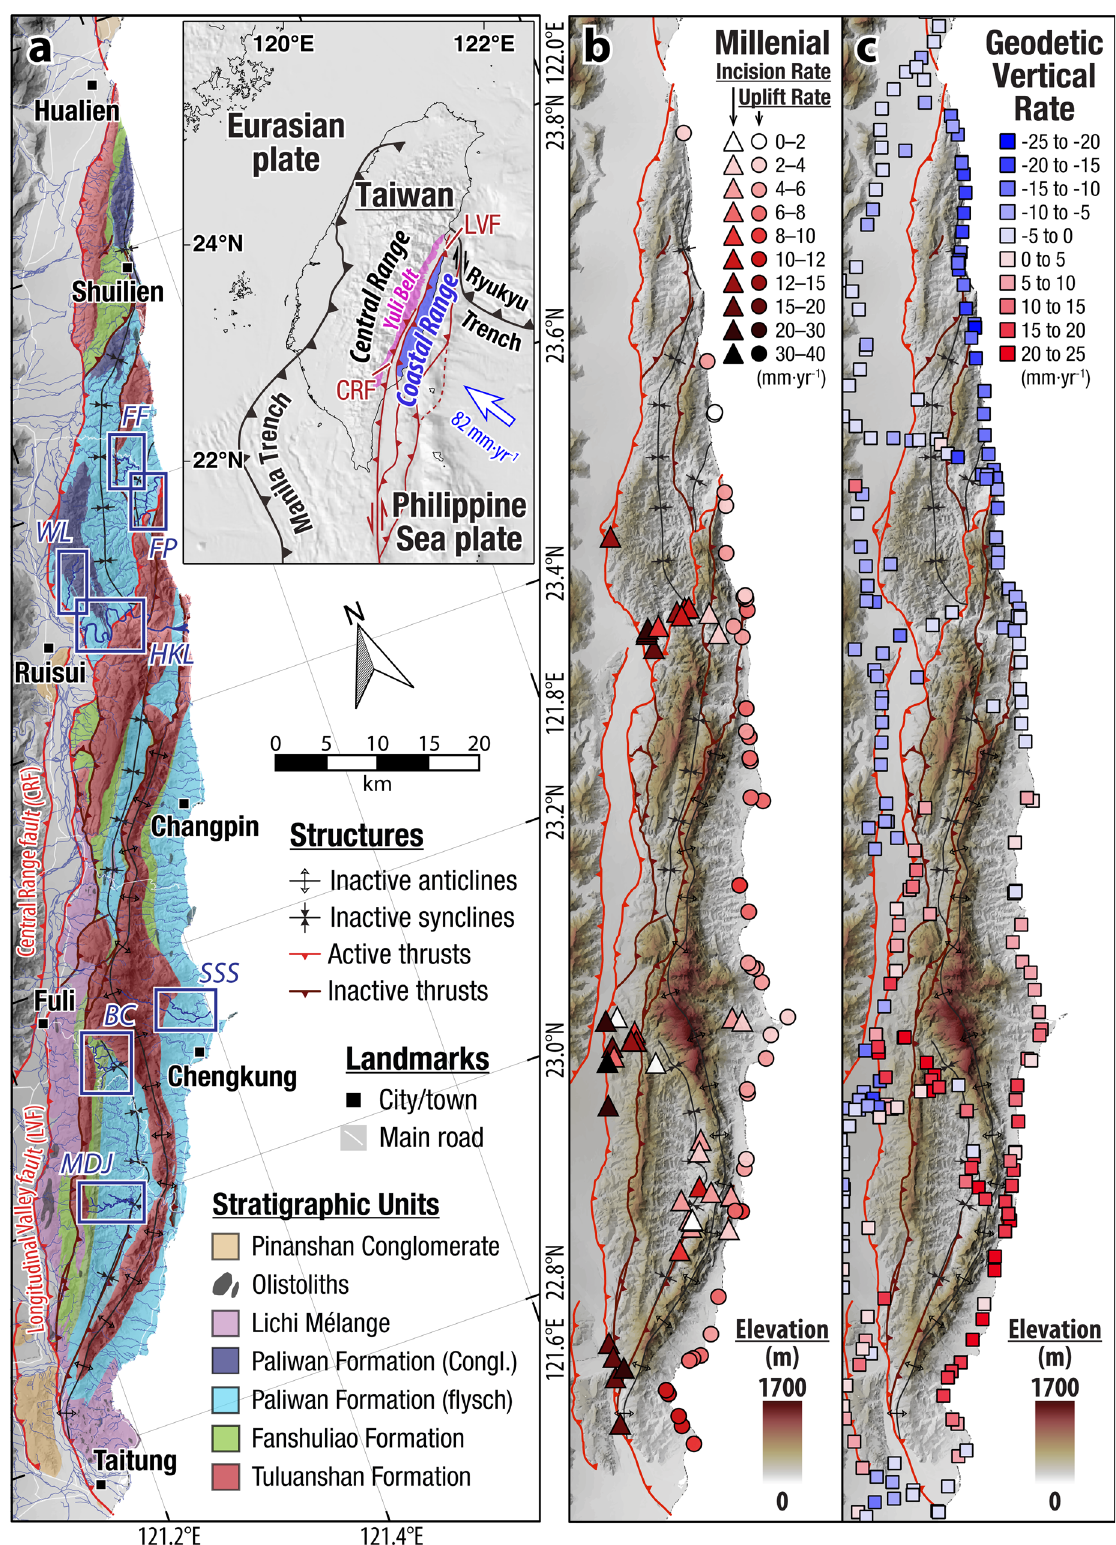
Fig. 1 The Coastal Range of eastern Taiwan. a Regional tectonic con fi guration 5,28 (inset), simpli fi ed geological map of the Coastal Range 34 and analyzed stratigraphic sections (blue boxes), including Hsiukuluan river (HKL), Wulou river (WL), Fungfu (FF), and Fungpin (FP) sections in the north, and Bieh river (BC), Madagida river (MDJ), and Sanshian river (SSS) sections in the south. b Millennial rates of marine terrace uplift and river incision, compiled by Lai et al. 99 c Geodetic rates of vertical deformation measured during 2000 – 2008 49 . Negative values mean subsidence.